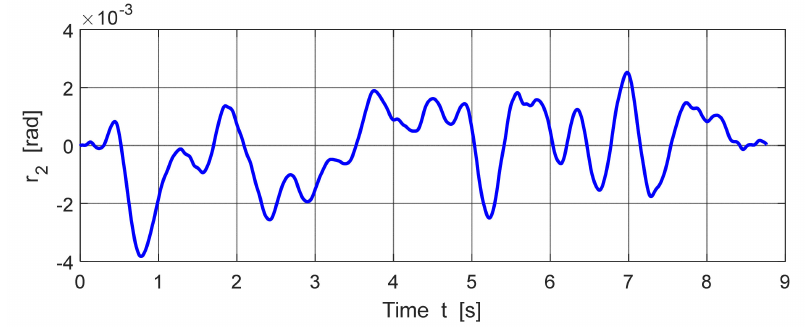
Figure 7. Angle of rotation of the sprung mass of vehicle in the longitudinal direction about an axis passing through the center of